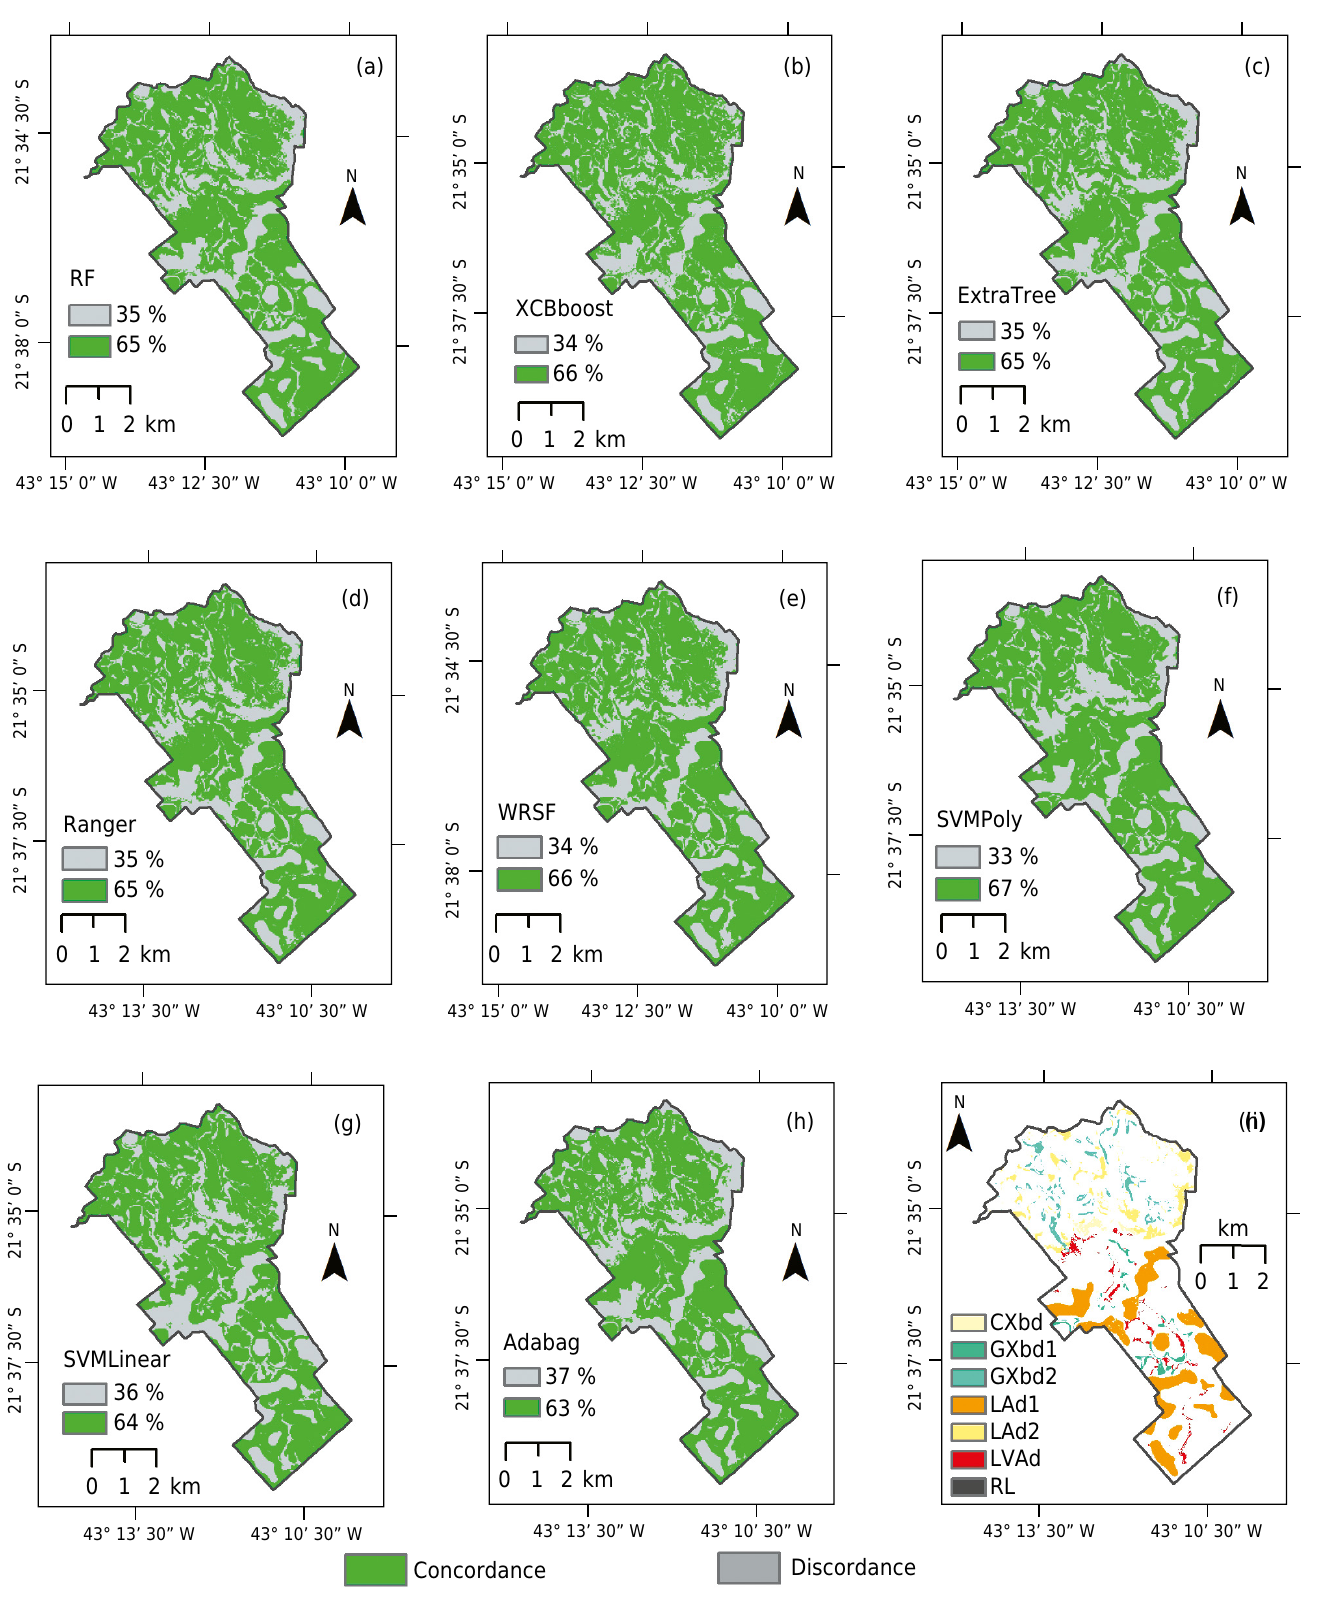
Figure 6. Map of concordance/discordance between the conventional soil map and digital soil mapping with the algorithms RF (a), xgBoost (b), ExtraTree (c), Ranger (d), WSRF (e), SVMPoly (f), SVMLinear (g), and AdaBag (h), and map of soils where discordance occurred in both mapping approaches, i.e., discordance with the conventional soil map, and discordance among the eight machine learning models (i). CXbd = Cambissolos Háplicos Tb Distróficos + Latossolos Amarelos Distróficos (CXbd + LAd); GXbd 1 = Gleissolos Háplicos Tb Distróficos (GXbd); GXbd2 = Gleissolos Háplicos Tb Distróficos + Cambissolos Háplicos Tb Distróficos (GXbd + CXbd); LAd1 = Latossolos Amarelos Distróficos (LAd); LAd2 = Latossolos Amarelos Distróficos + Latossolos Vermelho-Amarelos Distróficos + Cambissolos Háplicos Tb Distróficos (LAd + LVAd + CXbd); LVAd = Latossolos Vermelho-Amarelos Distróficos + Latossolos Amarelos Distróficos + Argissolos Vermelho-Amarelos Distróficos (LVAd + LAd + PVAd); RL = Neossolos Litólicos Distróficos + Cambissolos Háplicos Tb Distróficos (RLd +